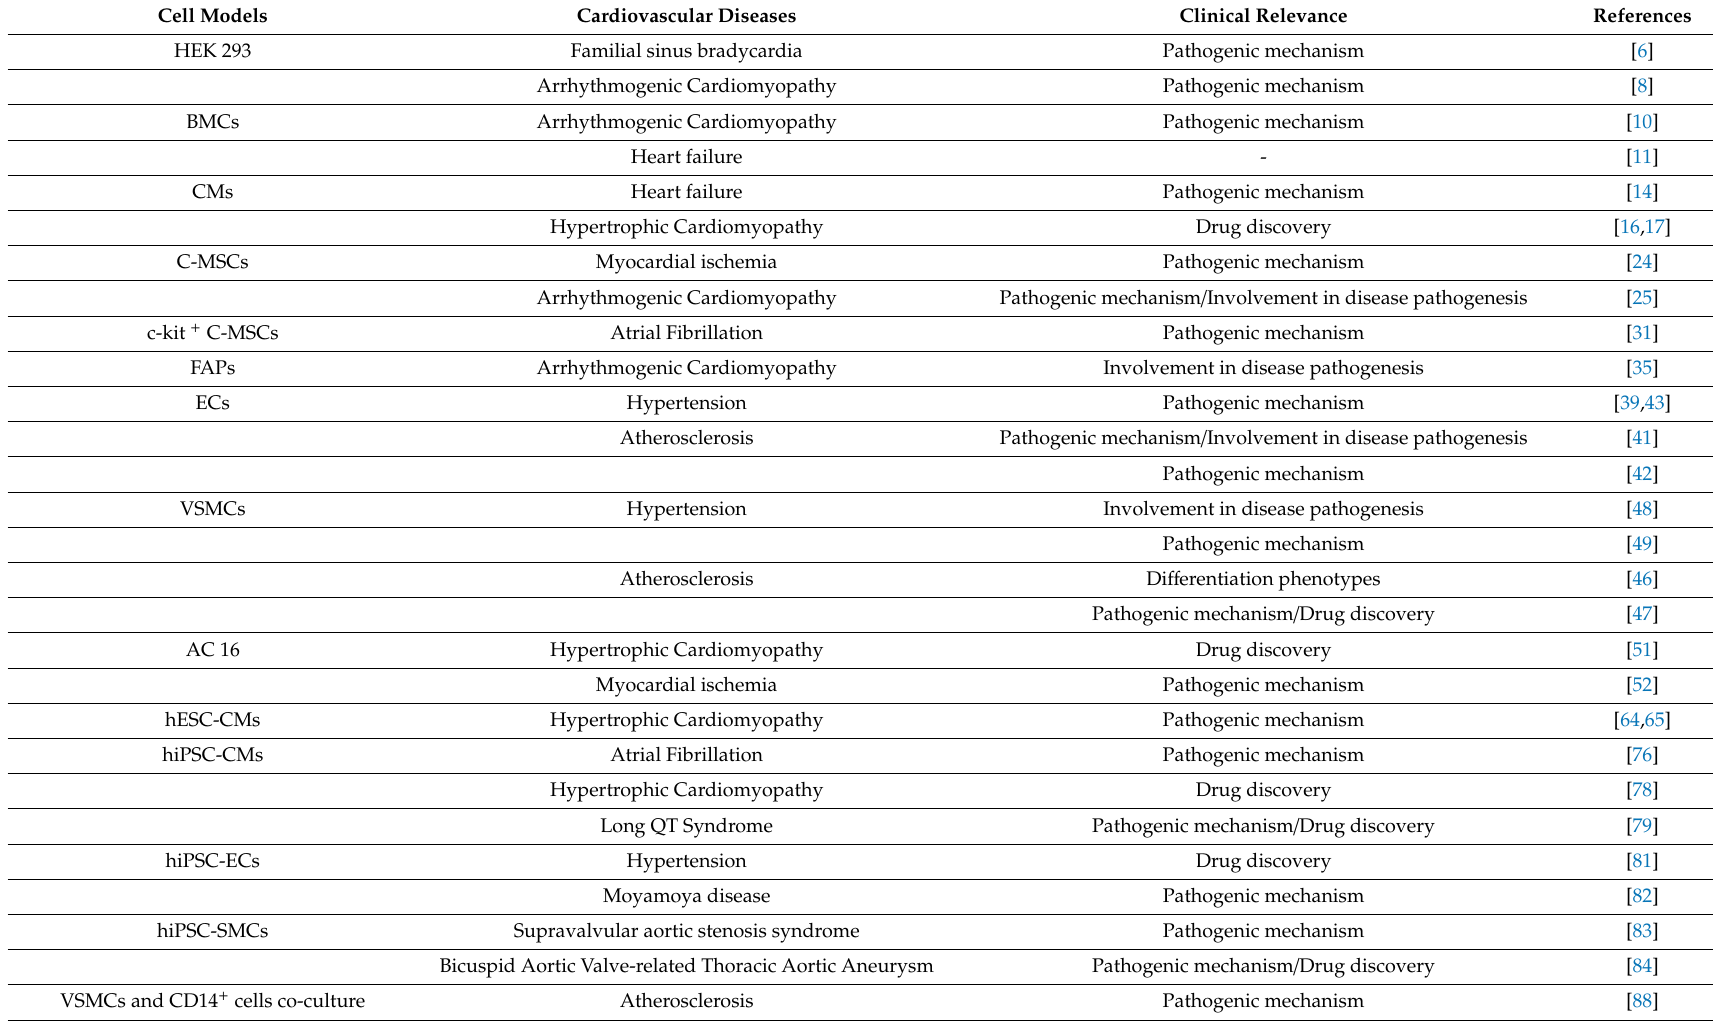
Table 1. Summary of mentioned examples of human cell modeling for cardiovascular diseases and the relative clinical